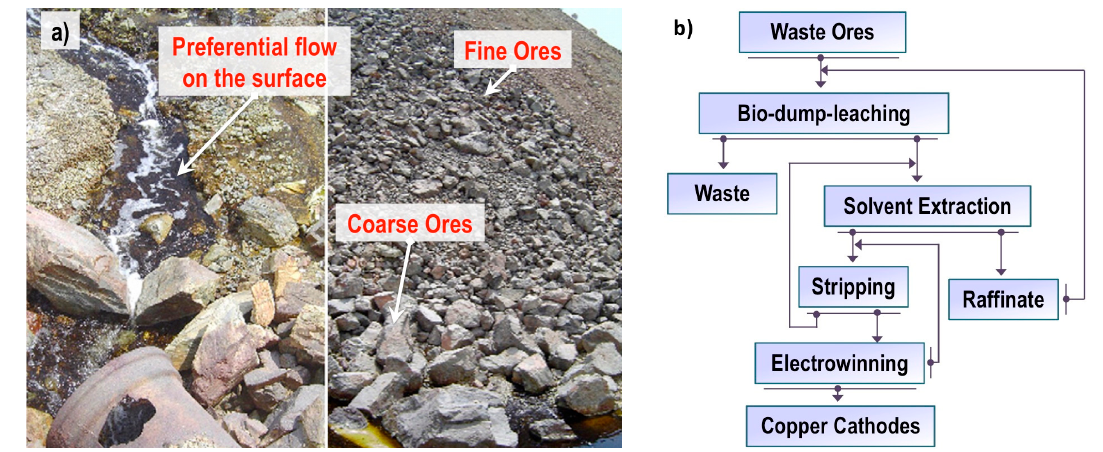
Figure 4. WRD and technological process of DCM. ( a ) Preferential flow and ore particle segregation; ( b ) Biodump leaching flowchart.